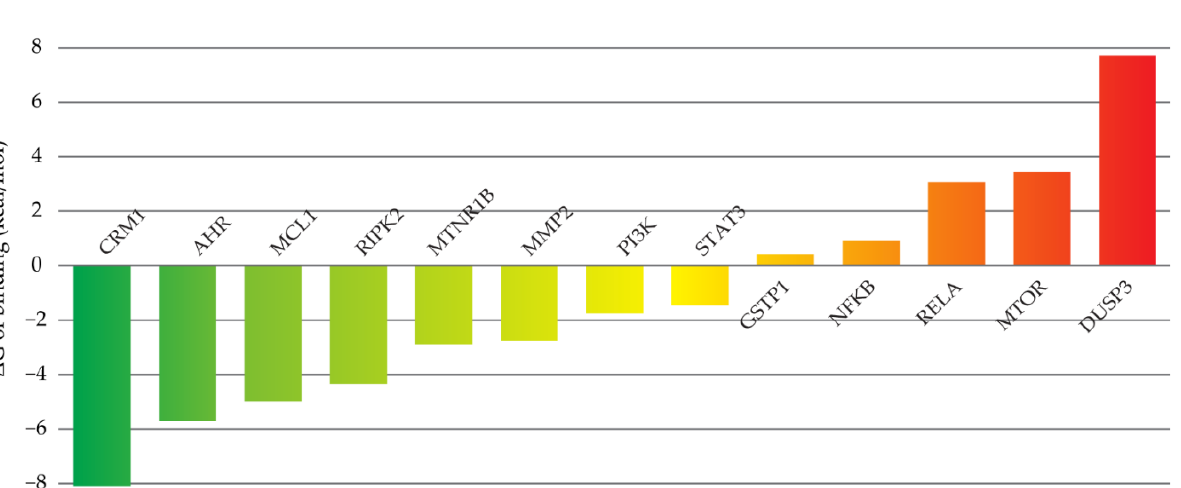
Figure 2. Predicted free energies of binding of compound 9 to its potential targets obtained from the MD simulations. The bars indicate the estimated error of the computed free energies of binding.